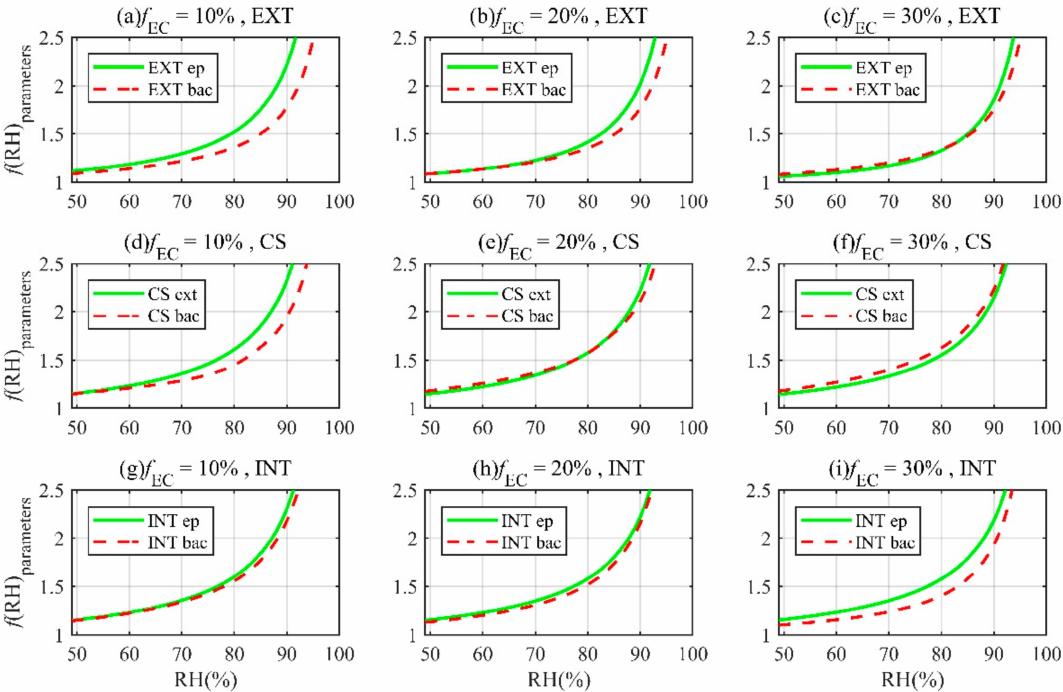
Figure 9. Hygroscopic enhancement factor diagram of optical parameters; the abscissa and ordinate represent the relative humidity and hygroscopic enhancement factor of optical parameters, respec- tively. ( a – c ) represent the EXT cases where the fractions of EC are 10%, 20% and 30%, respectively. ( d – f ) represent the CS cases where the fractions of EC are 10%, 20% and 30%, respectively. ( g – i ) represent the INT cases where the fractions of EC are 10%, 20% and 30%,